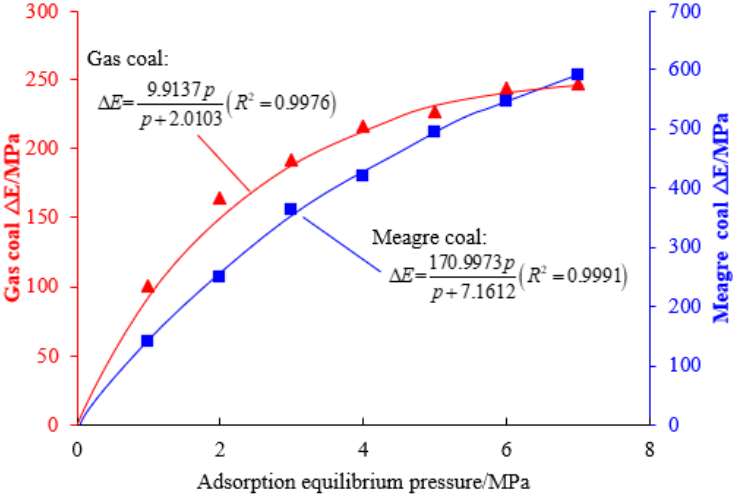
Figure 6. Reduction in elastic modulus vs. equilibrium pressure for methane adsorption.